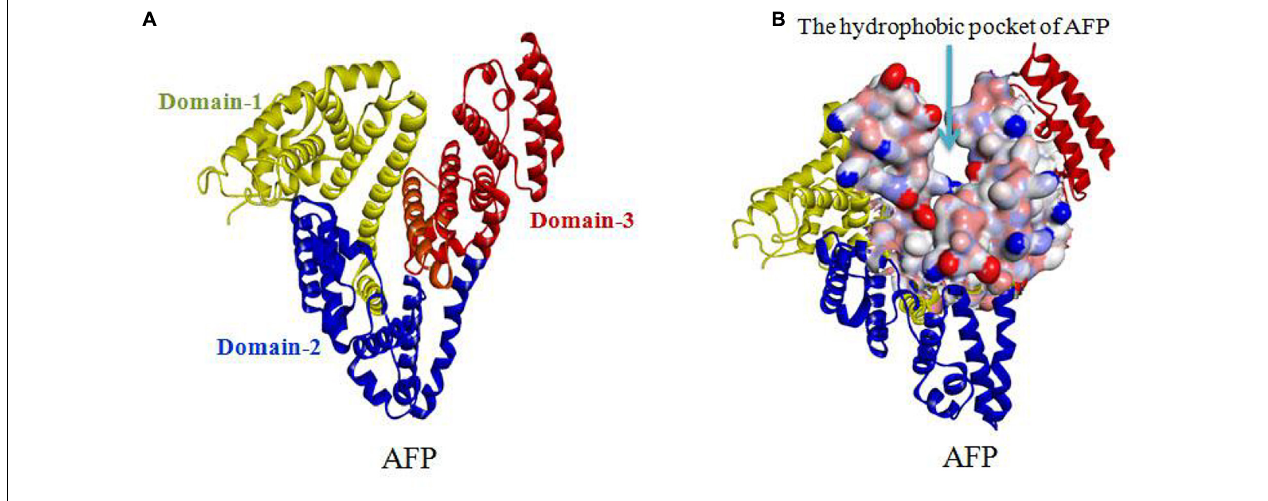
FIGURE 3 | V-shaped AFP and its hydrophobic pocket. (A) Overall V-shaped structure of AFP comprised of three domains. Domain-1 (yellow) and domain-3 (red) are located on each side of the V-shape, and domain-2 (blue) is located at the bottom of the V-shape. (B) A hydrophobic pocket is formed between domain1